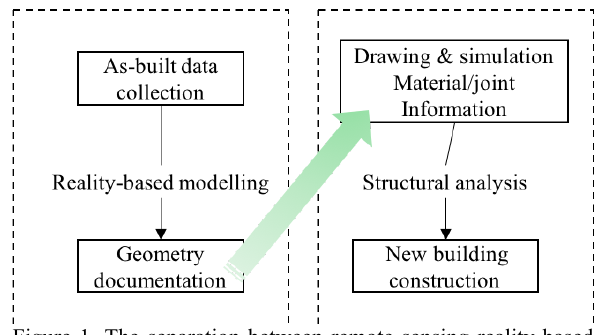
Figure 1. The separation between remote sensing reality-based modelling and civil engineering structural analysis dealing with beam framed historic roof